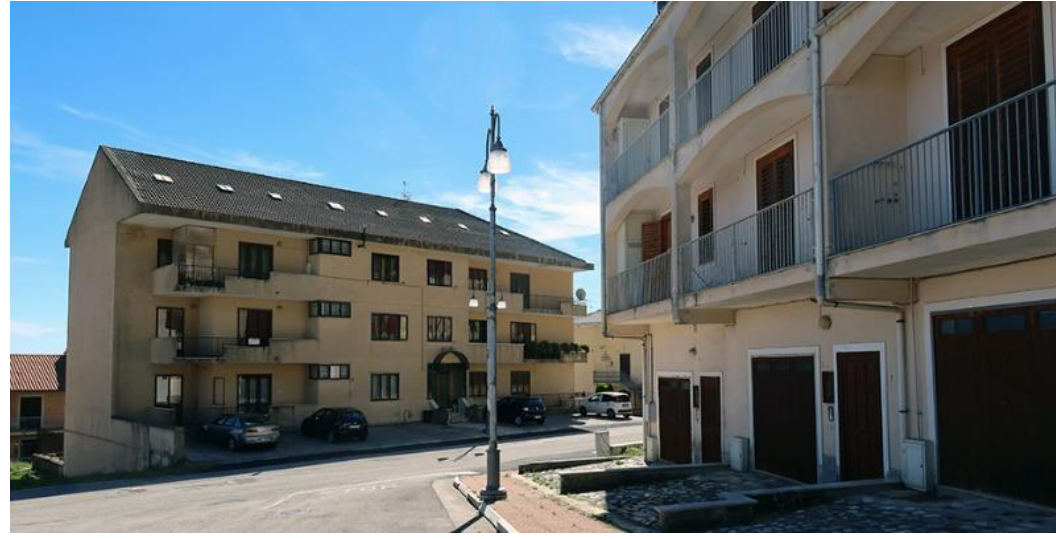
Figure 98. Senerchia: details of the new buildings (photos by [35,36]).